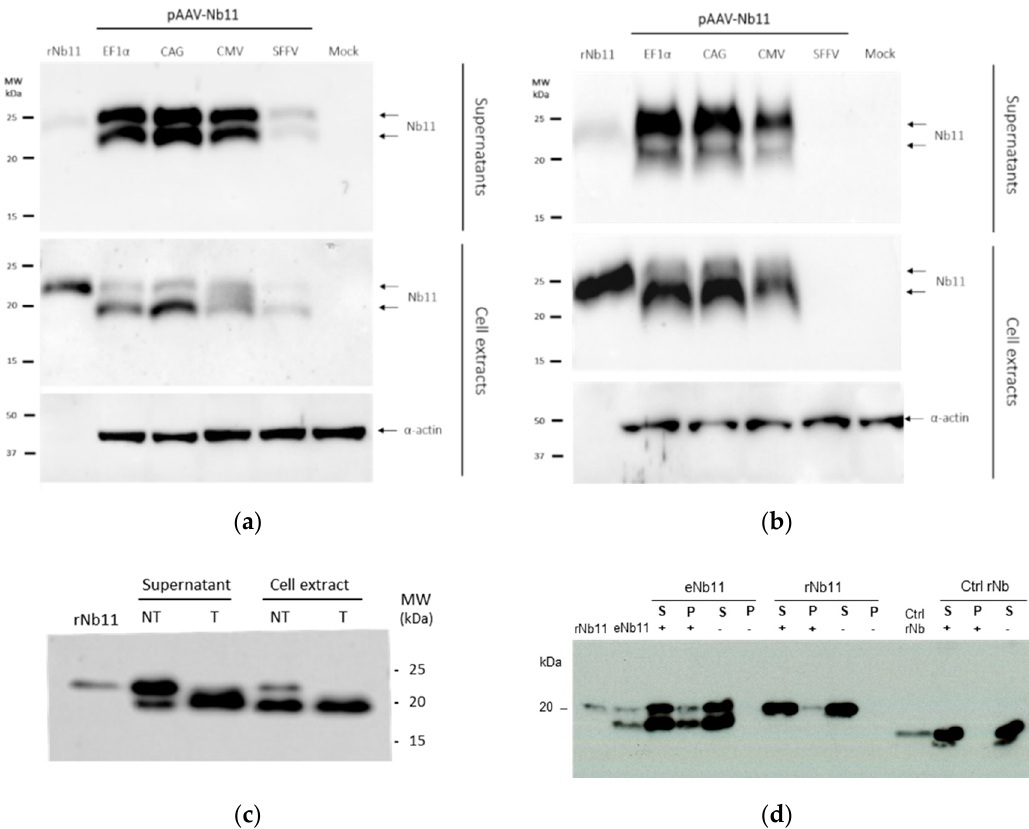
Figure 5. Western blot analysis of Nb11 expressed from eukaryotic cells In vitro . Supernatant (S) and cell extracts from ( a ) BHK and ( b ) HuH-7 cells transfected with AAV plasmids coding for Nb11, under the promoters indicated above the gels, were analyzed by Western blot using an anti-HA antibody. Nb11 in HuH-7 cell samples transfected with pAAV-SFFV-Nb11 could not be detected in this analysis. Twenty nanograms of rNb11 (produced in bacteria) were loaded as control. ( c ) Analysis of glycosylation in supernatant and cell extracts from BHK cells transfected with pAAV-EF1 α -Nb11 that were treated (T) or non-treated (NT) with a mix of N-and O-glycosidases. ( d ) Immunoprecipitation of Nb11 using mPD-1. Supernatants from BHK cells transfected with pAAV-EF1 α -Nb11 (eNb11) or rNb11 were incubated with microbeads coated ( + ) or uncoated ( − ) with mPD-1-Fc. After incubation, microbeads were magnetized and the mPD-1-bound fraction (P: precipitated) or unbound fraction (S: soluble) were separated for Western blot analysis using an anti-HA antibody. Ctrl rNb, recombinant control Nb having an HA tag with no relevant specificity.